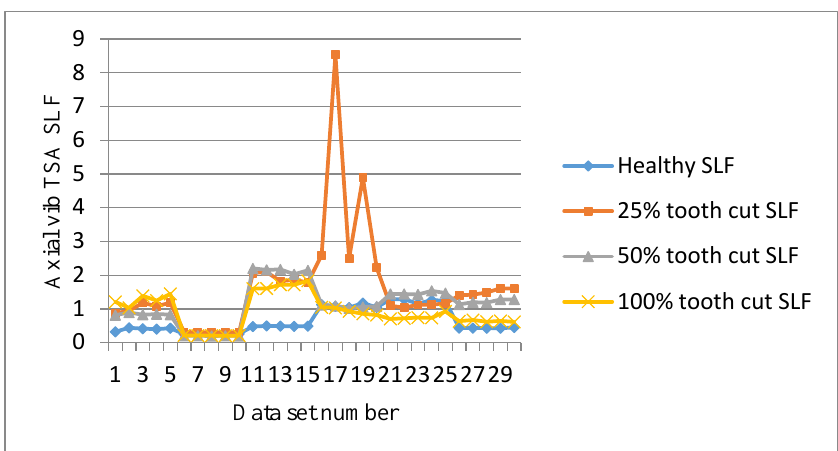
Figure 14. SLF of axial vibration TSA signals.